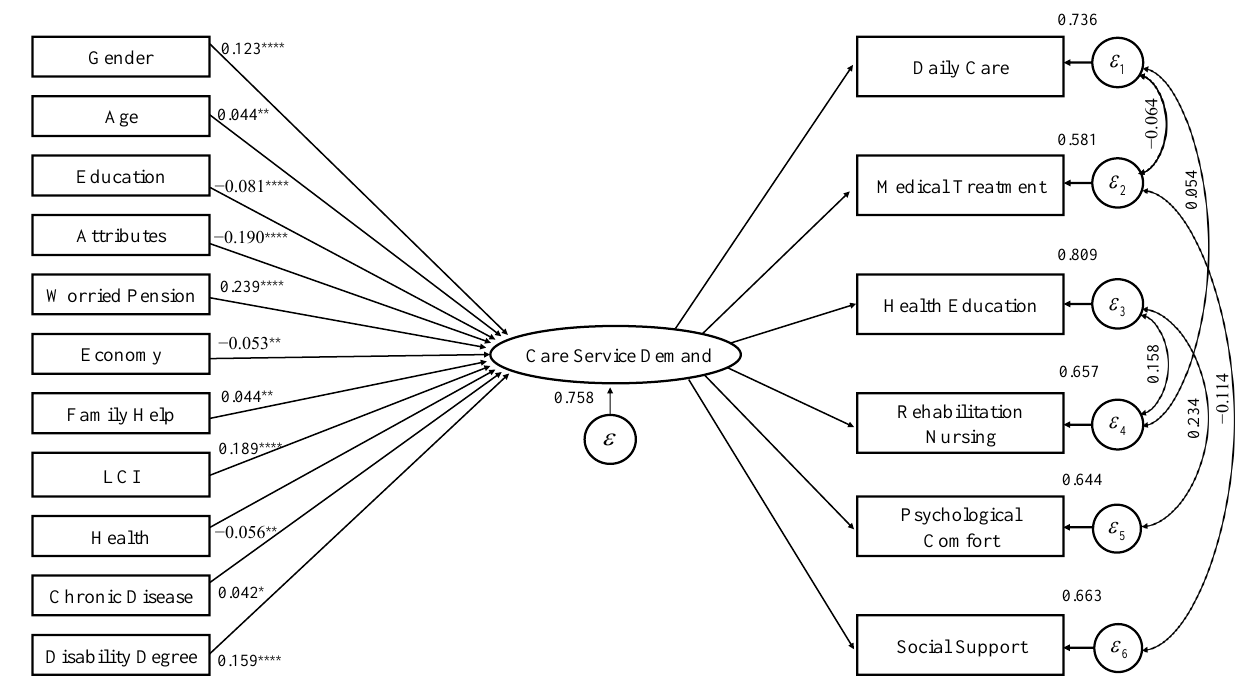
Figure 5. Results of MIMIC model of influencing factors of care service demand. Note: The estimation method is ML, report the standardized coefficient is, ****, **, * are significant at the levels of 0.1%, 1%, 5% and 10% respectively. Table 3. Results of model regression of factors influencing the demand for care services for the dis- abled.